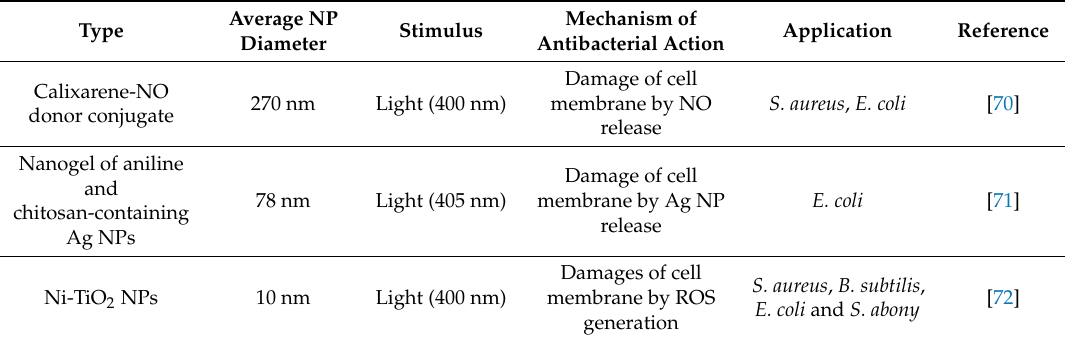
Table 1. Examples of stimuli-responsive nanoantibiotics